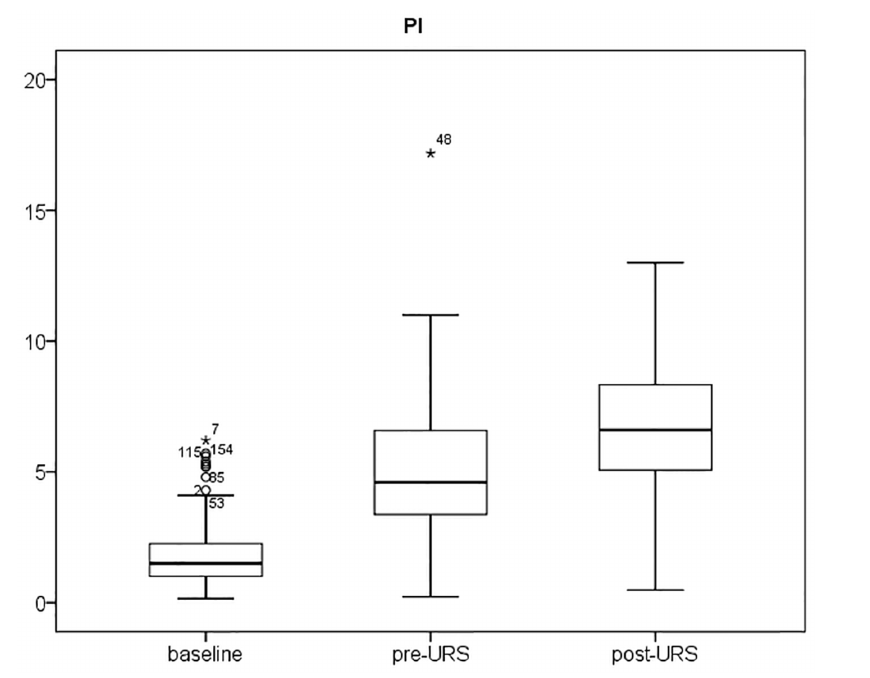
Fig. 1. Interquartile range (IQR) of Perfusion Index (PI) in patients with Grade I, II, and III hydronephrosis. The PI increased after induction of anesthesia, and increased further after stone